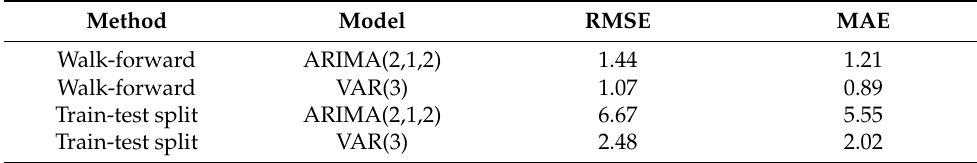
Figure 7. ( a ) Predicted numerical results for walk-forward validation method by VAR(3); ( b ) Predicted numerical results for train-test split validation method by VAR(3). Table 3. Comparison of predicting performance between VAR(3) and